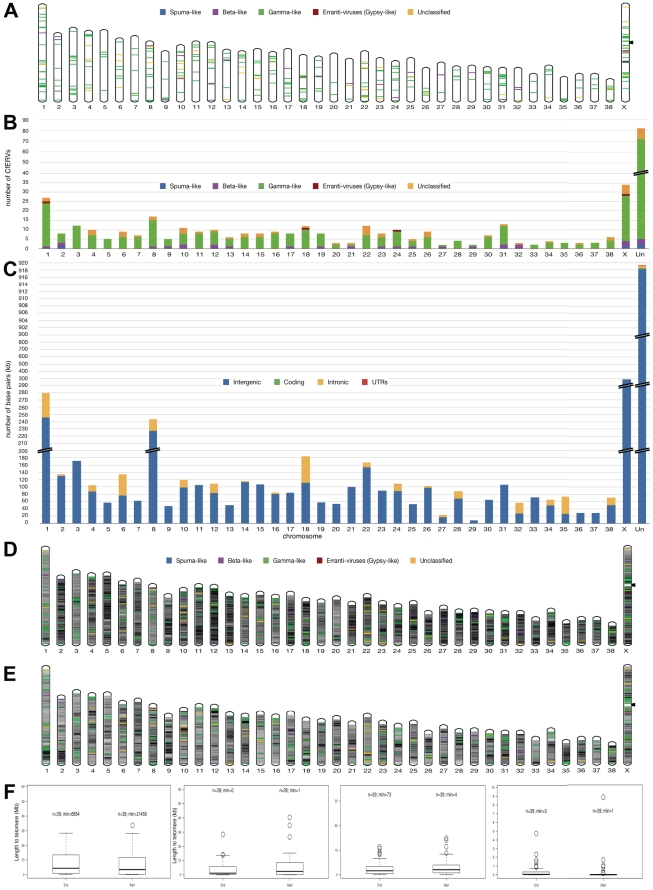
A) Chromosomal distribution of CfERVs. Every CfERV is placed into its chromosomal position rescaled to a megabase (Mb) size bin to be noticeable in the chromosomal picture. A color code is assigned depending on its classified genus. Non-acrocentric chromosomes (chrX) present arrows point at their centromeres. B) Cumulative histogram distinguishing the numbers and genus categories of CfERVs distributed per chromosome. Breaks in bar plots indicate scale changes. C) Cumulative histogram with the CfERV amount of nucleotides contained in exonic, intronic, intergenic or untranslated (UTR) regions per chromosome analyzed. Breaks in bar plots indicate scale changes. D) LINEs (old non-LTR transposable integrations); E) SINE_Cf (newer non-autonomous integrations in dogs). Repeats are grouped in bins to a resolution of 1 Mbp. Relative chromosomal occupancy by these elements of a bin is symbolized by the degree of hue in a grey color scale (darkest, higher). Herein, every CfERV is denoted as specified before. F) Distances to telomeres. The boxplot “Start” describes the distribution of CfERV (or repeat) distances to the telomere at the start of the chromosome, the “End” group is towards the other end of the chromosome. In this graph, the number of elements is represented by ‘n’ (number of chromosomes) and the minimum value in the distribution is ‘min’ for sake of clarity. A number of 0 indicates the fact that an integration of repeat(CfERV) in a telomere exists. Note the different scale in measures (in bp) between images (from left to right): CfERVs contained in each chromosome, LINEs, SINEs-Cf, and repeats without difference of class/type annotated by RepetMasker.